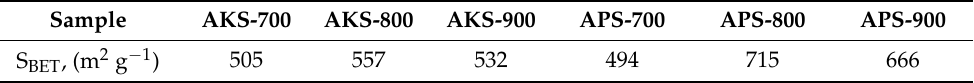
Table 1. The specific surface area of the activated carbons based on karagash and pine sawdust. Sample